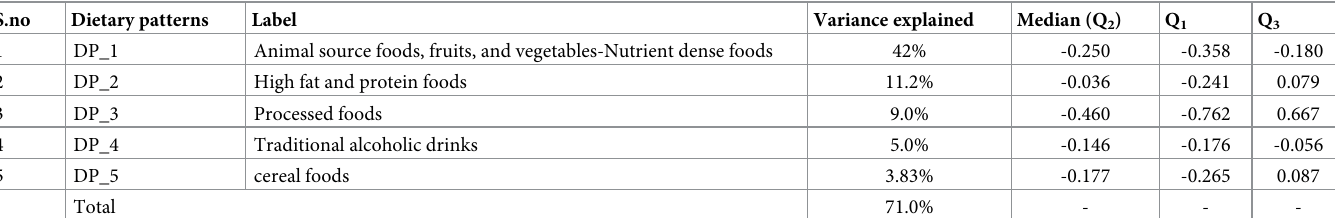
Table 2. Total variance explained and summary statistics for factor scores for identified dietary patterns in Ethiopia. S.no Dietary patterns Label Animal source foods, fruits, and vegetables-Nutrient dense